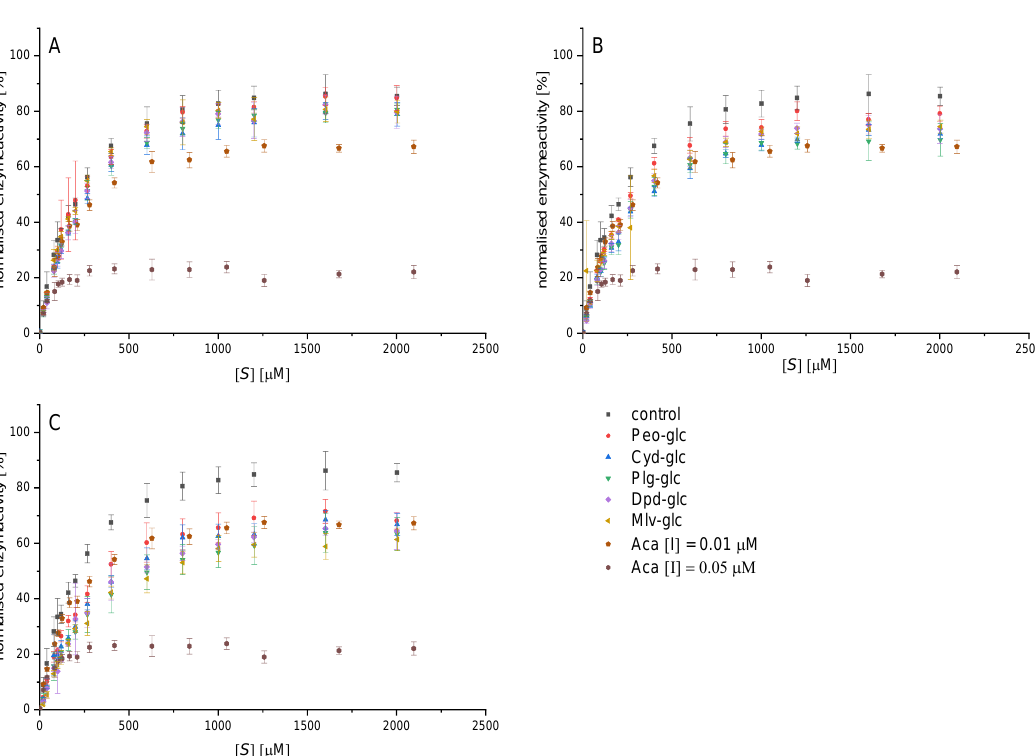
Figure 3. Decrease in conversion rate of 2-chloro-4-nitrophenyl-4-O-ß-galactopyranosyl maltoside (GalG 2 CNP) by addition of 12.5 ( A ), 25 ( B ), and 50 µM ( C ) anthocyanin-3-glucosides and 0.01 and 0.05 µM acarbose, normalized on the v max value of the uninhibited reaction. Abbr.: [S], substrate concentration; Plg-3-glc, pelargonidin-3-glucoside; Cyd-3-glc, cyanidin-3-glucoside; Dpd-3-glc, delphinidin-3-glucoside; Peo-3-glc, peonidin-3-glucoside; Mlv-3-glc # , malvidin-3-glucoside; ACA # , acarbose; # values already published by Kaeswurm et al. [16].